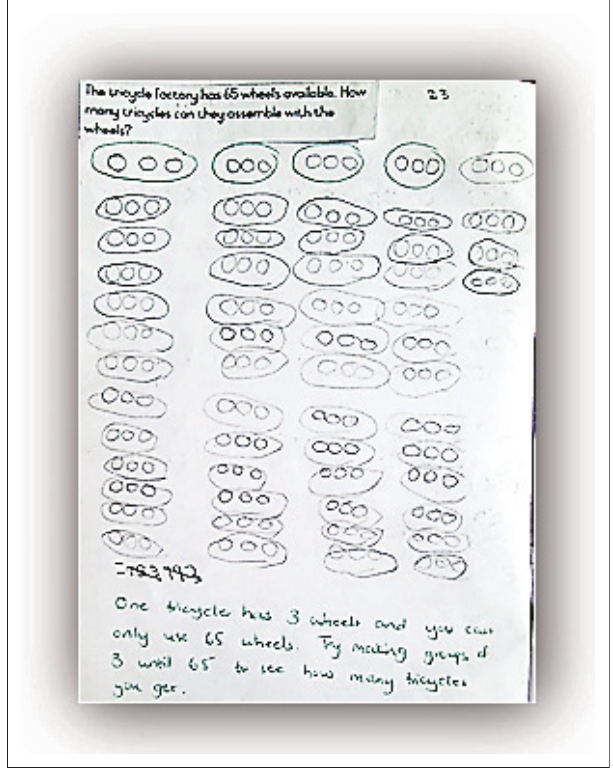
FIGURE 6: Jarred (Intervention-Problem 5).